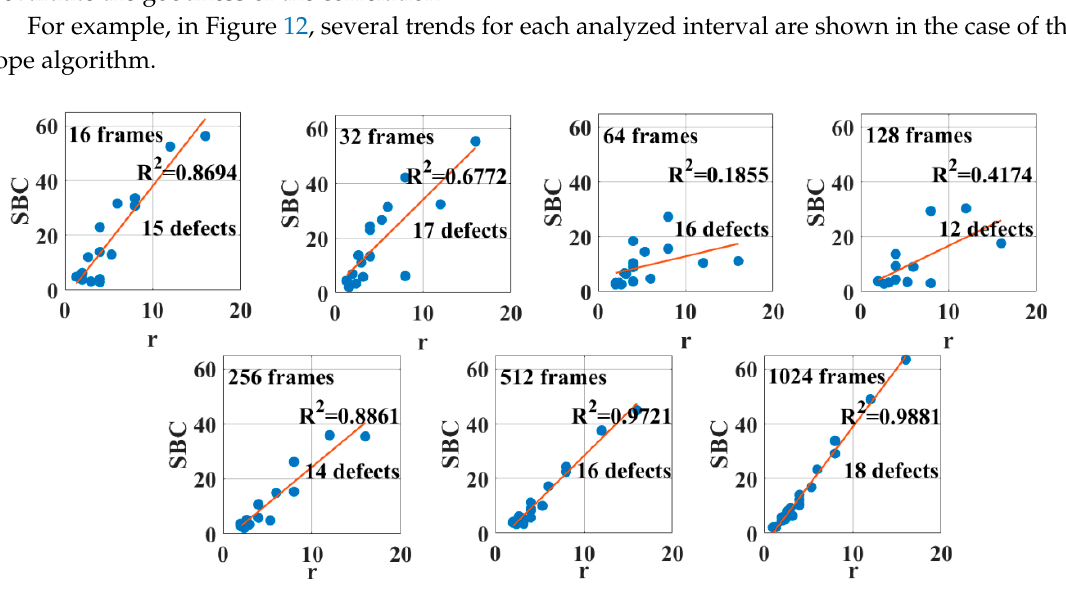
Figure 12. SBC values for the Slope algorithm and for different frame intervals.